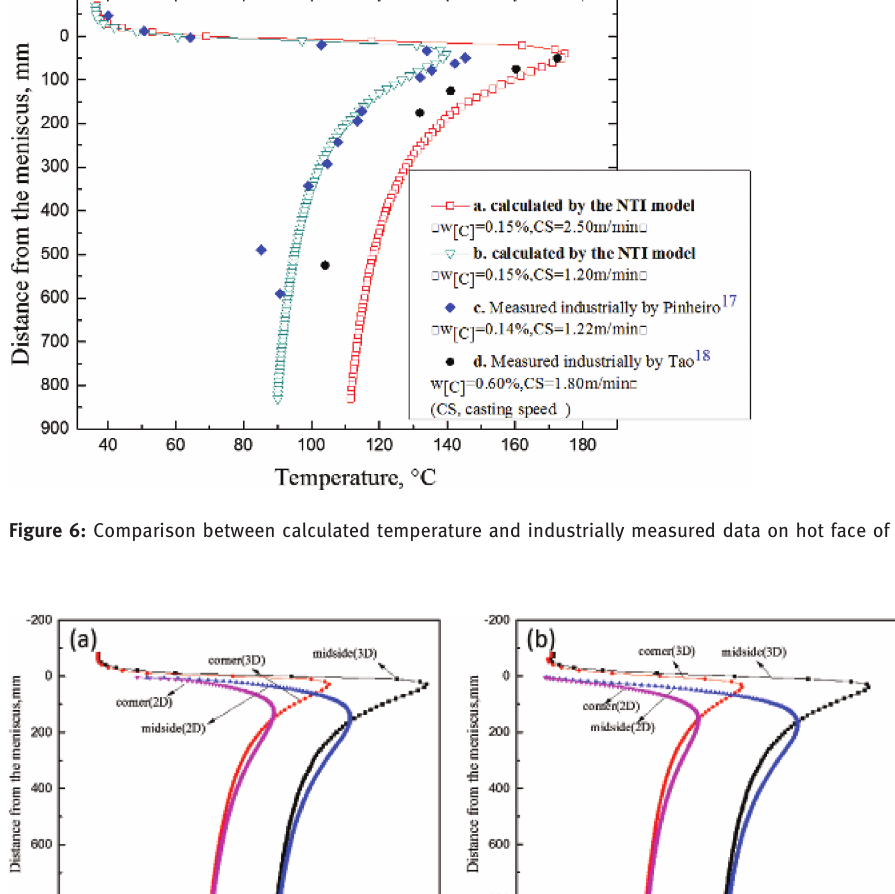
thickness did not cause the highest temperature position to change. However, with increasing scale thickness, the high-